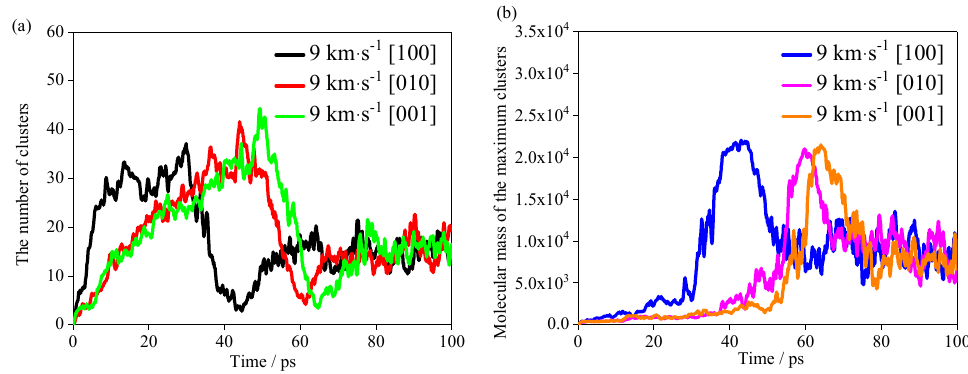
Figure 9. ( a ) Evolution of the number of the clusters. ( b ) Molecular mass of the maximum clusters.